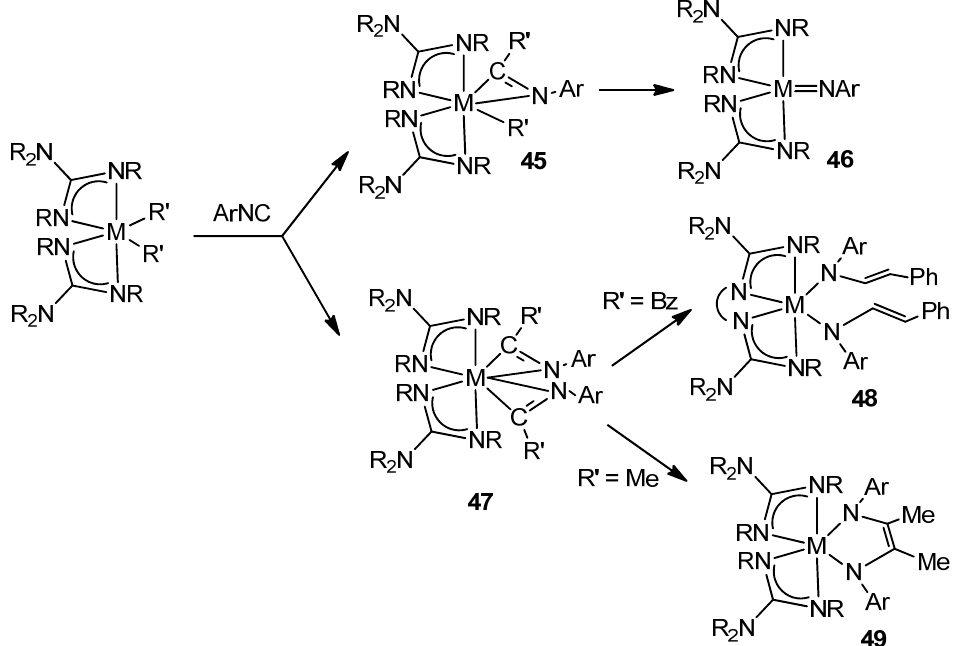
Figure 28. Aryl isonitriles insertion and the consecutive evolution of the iminoacyl groups.